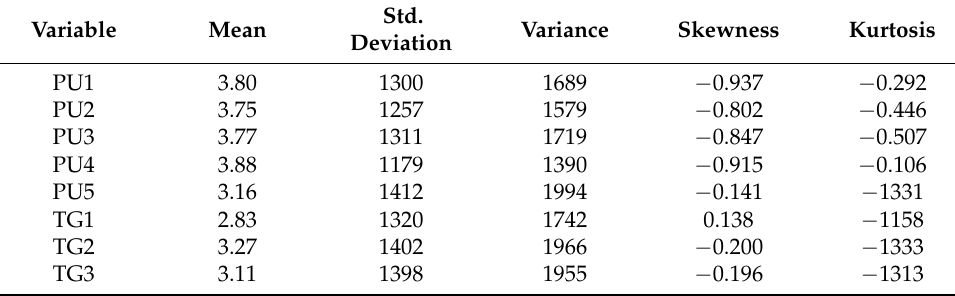
Table 2. Descriptive statistics of model